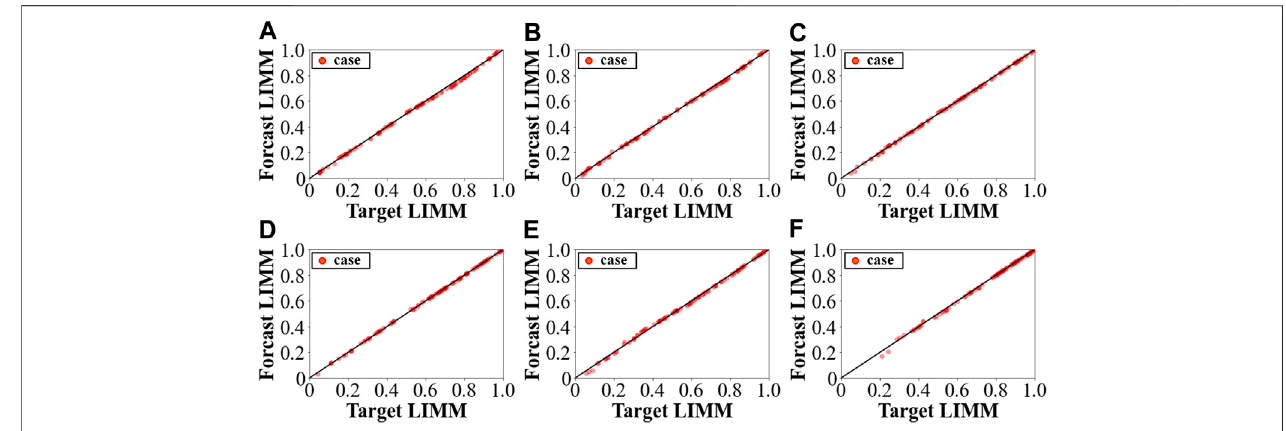
FIGURE7| LIMM valueprediction performancesofdifferentbuses ofIEEE118-bus system. (A) Node29 (B) Node41 (C) Node 28 (D) Node 115 (E) Node114 (F) Node 109.